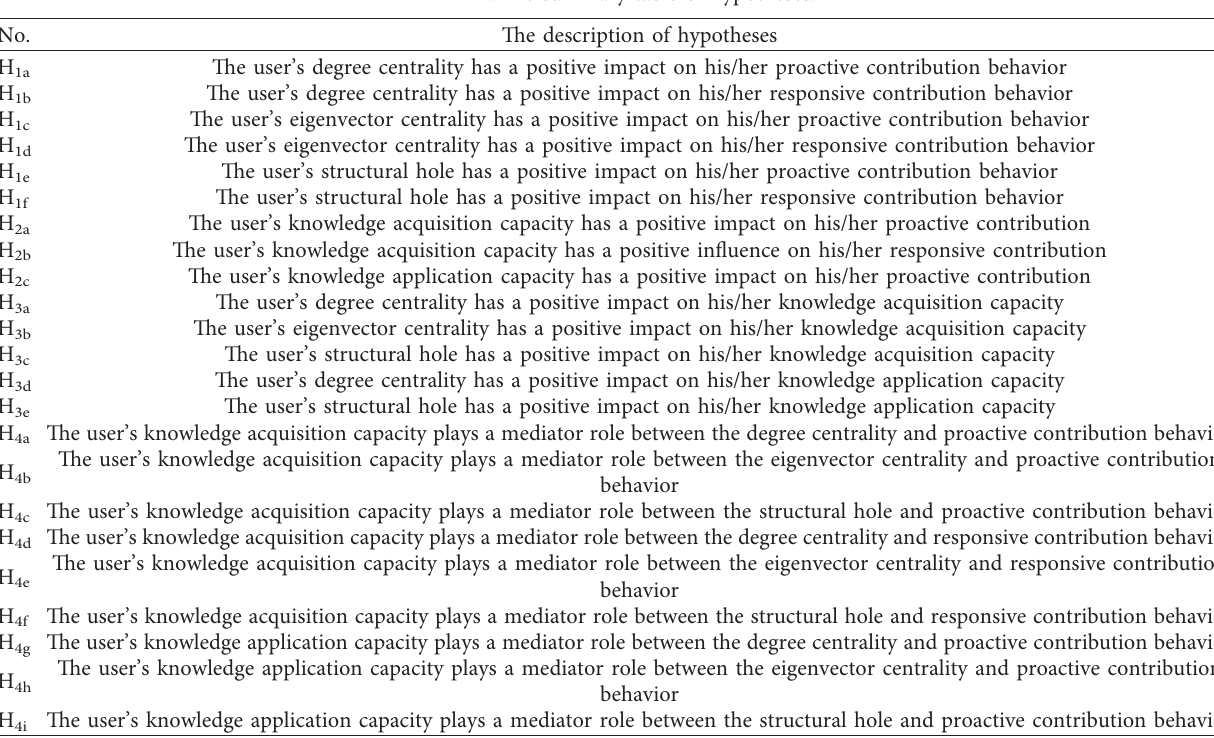
Table 1: The summary table of